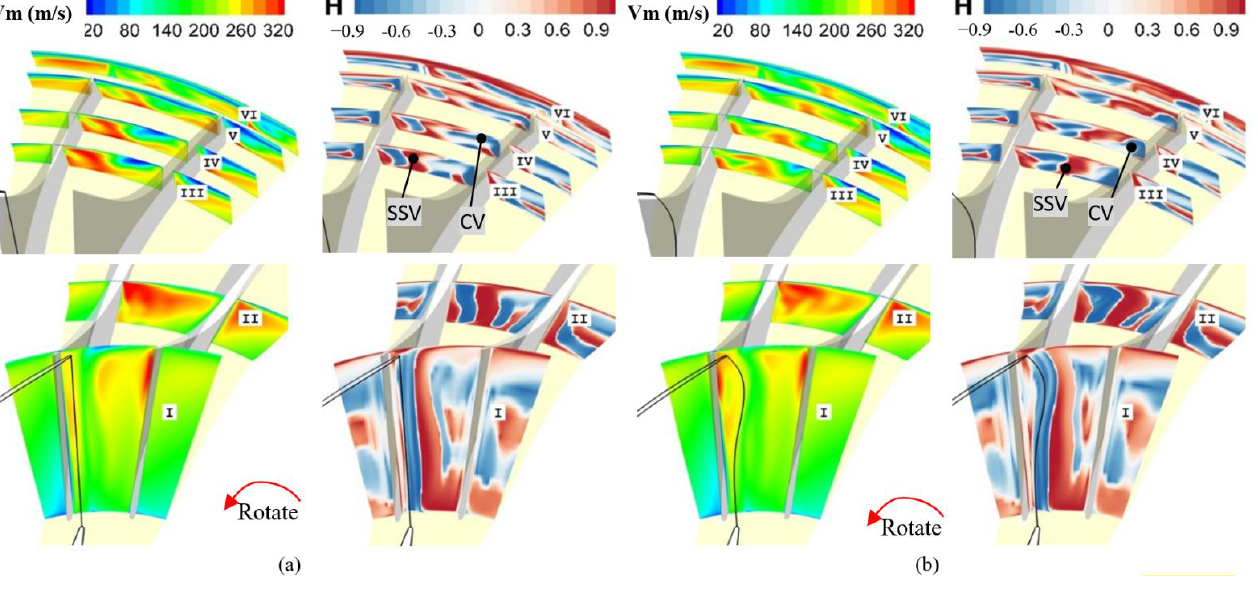
Figure 26. Evolution of the relative helicity and meridional velocity within the baseline and free- formed tandem impeller passages. ( a ) Baseline tandem impeller, and ( b ) free-formed tandem impeller.